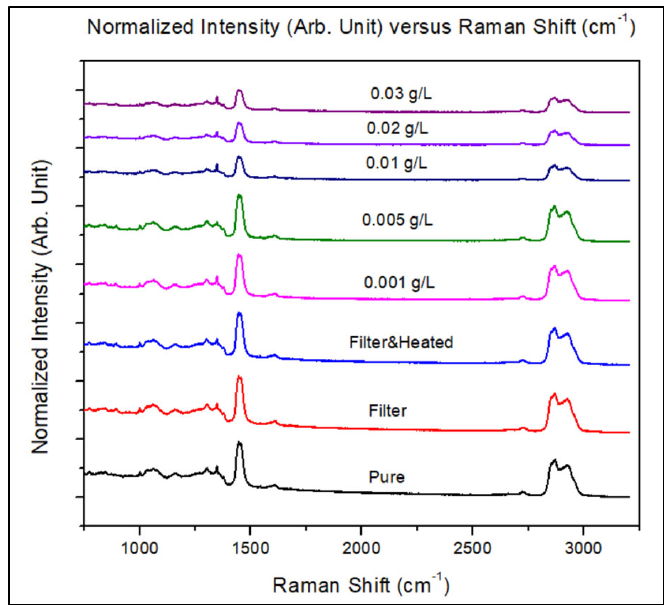
Figure 12. Raman spectra of different types of samples.